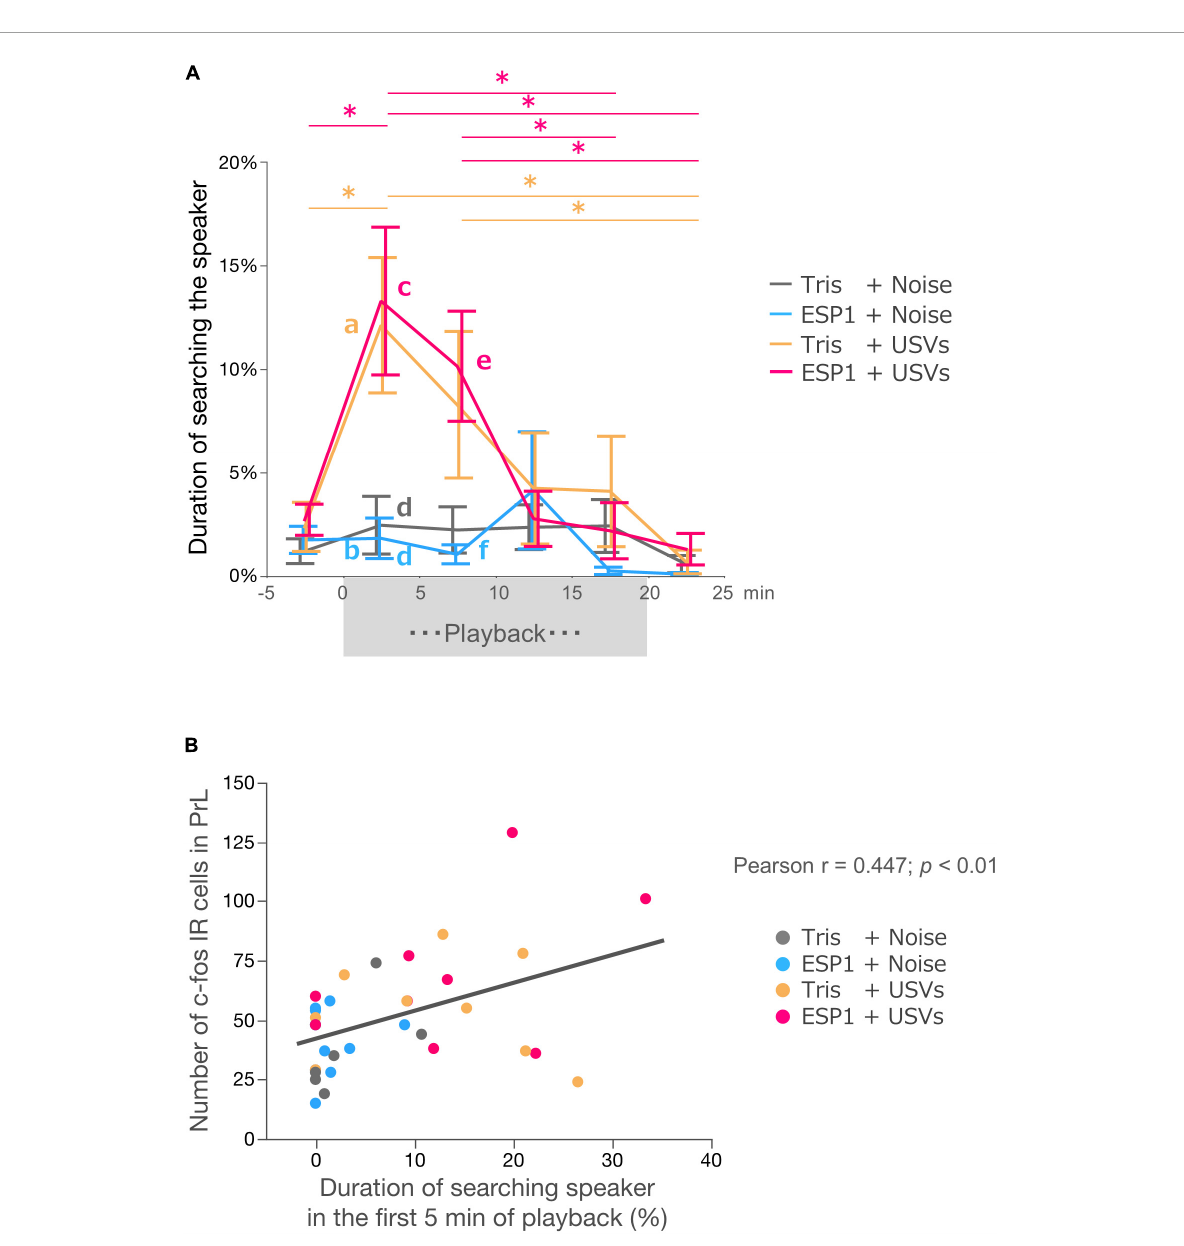
FIGURE7 Neural activation in PrL correlates with exploration behavior. (A) Duration of speaker exploratory behavior. The whole period was divided into 5-min time windows. Colors represent experimental groups. The (exocrine gland-secreting peptide 1) ESP1+USVs (ultrasonic vocalizations) and Tris+USVs groups showed significantly longer exploration time during the first 5 min and 5–10 min after the start of playback than during the 5 min before playback, 15–20 min after playback, and 5 min after the end of playback. Data points indicate mean ± SEM. ∗ p = 0.05, Two-way ANOVA, Bonferroni test. The Tris+USVs and ESP1+USVs groups had significantly longer speaker exploration times than the Tris+ noise and ESP1+USVs groups during the first 5 min after playback and 5–10 min after playback. Different letters indicate significant differences ( p <